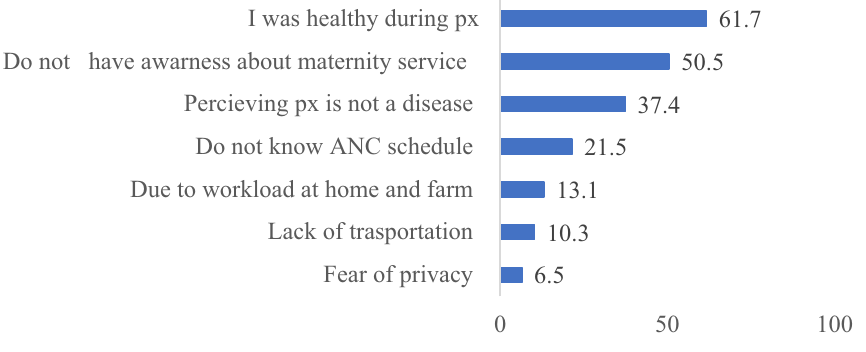
Figure 2. Reasons for antenatal care visits non-attendance in Northwest Ethiopia, 2020.